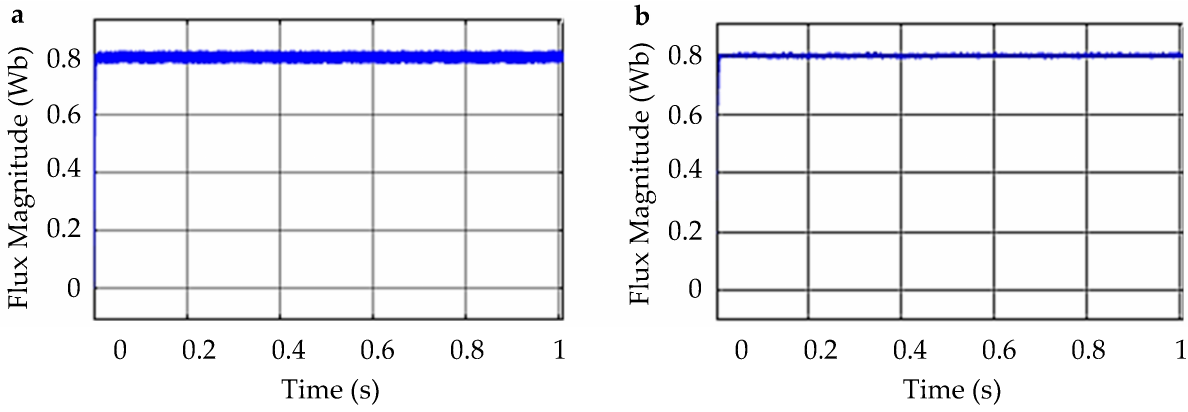
Figure 13. Stator phase current under load during startup and steady state.